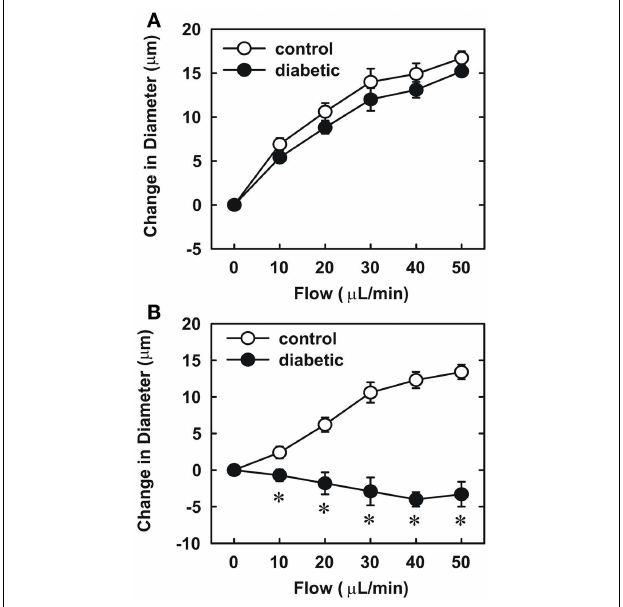
FIGURE 4 | Effect of arginine on flow-dependent increases in internal diameter of gracilis muscle arterioles . Arterioles isolated from control (open symbol) or diabetic (closed symbol) rats were treated in vitro with the L-arginine (1mM) (A) or D-arginine (1mM) (B) and then exposed to graded levels of luminal flow. Results are expressed as mean ± SEM ( n = 4–5). * Statistically significant effect of diabetes ( p < 0.01).